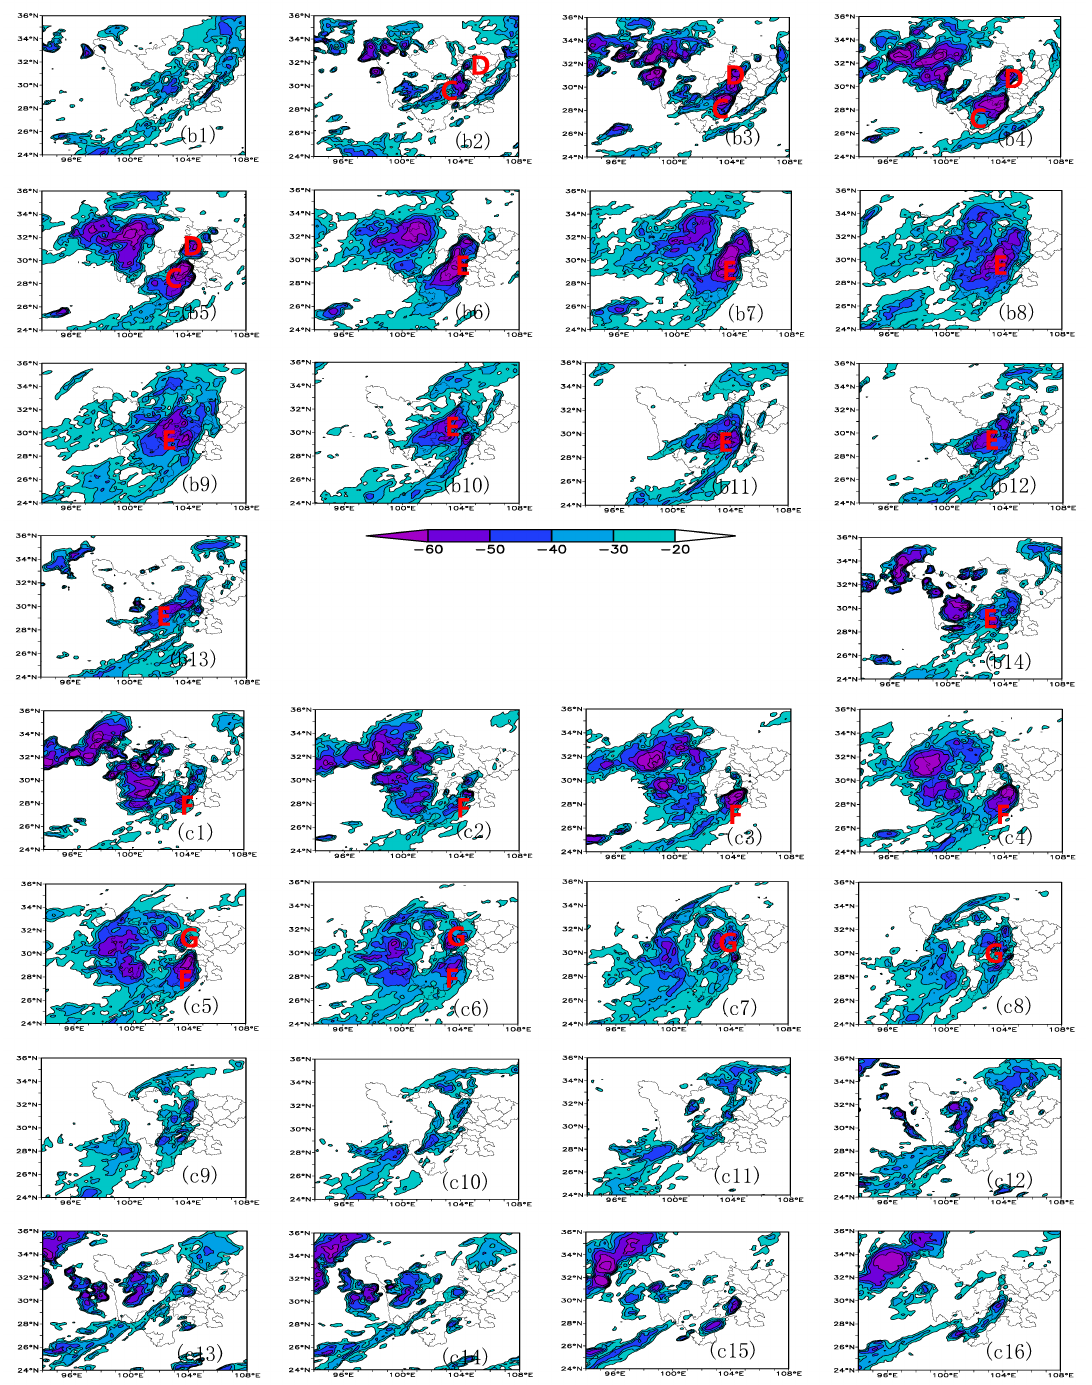
Figure 3. The Tb distribution of the first ( a1 – a8 ), second ( b1 – b14 ) and third period ( c1 – c16 ) in intervals of 2 h: ( a1 ) 1400 UTC 7